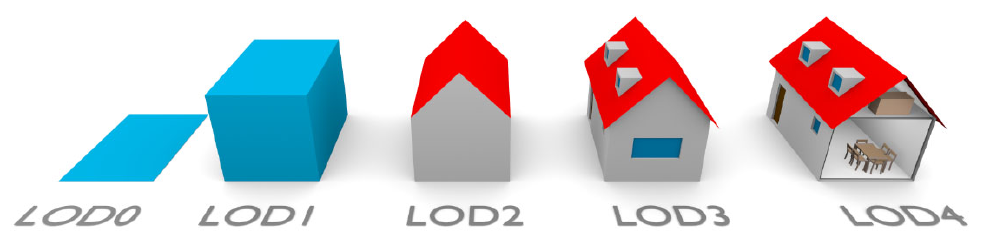
Figure 1. The five LODS of buildings in CityGML (image from